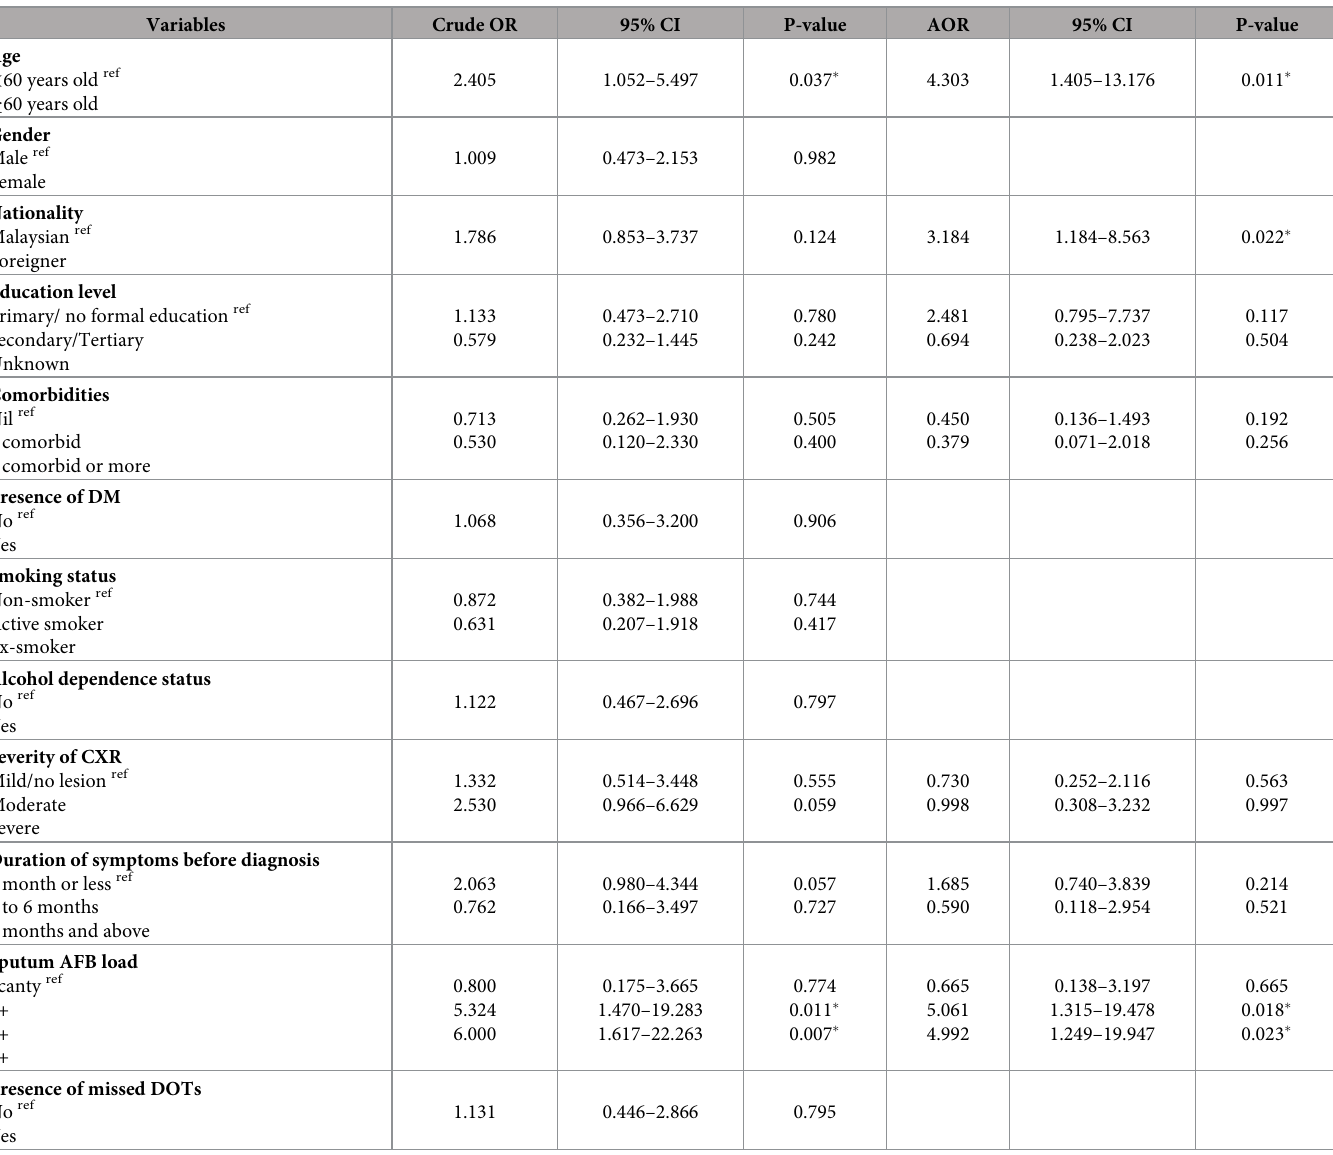
Table 3. Bivariable and multivariable logistic regression for association of sociodemographic and clinical variables with delayed sputum smear conversion.